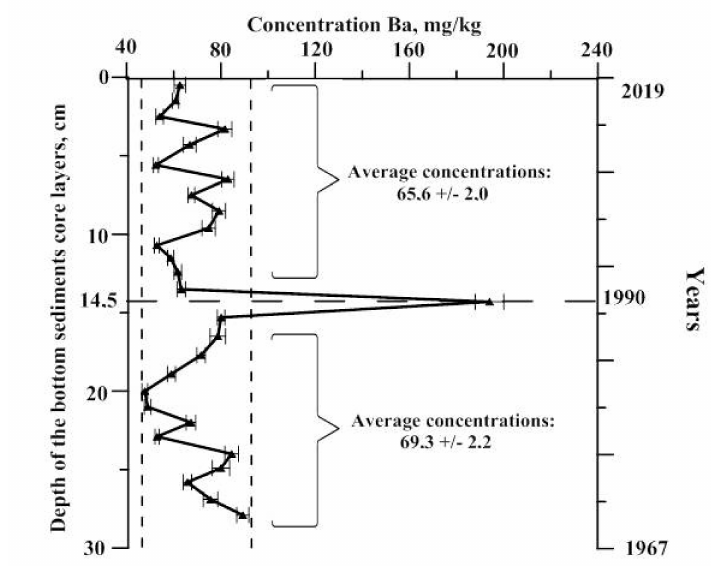
Figure 5. Distribution of Ba (stable isotope) in the core of bottom sediments of Lake